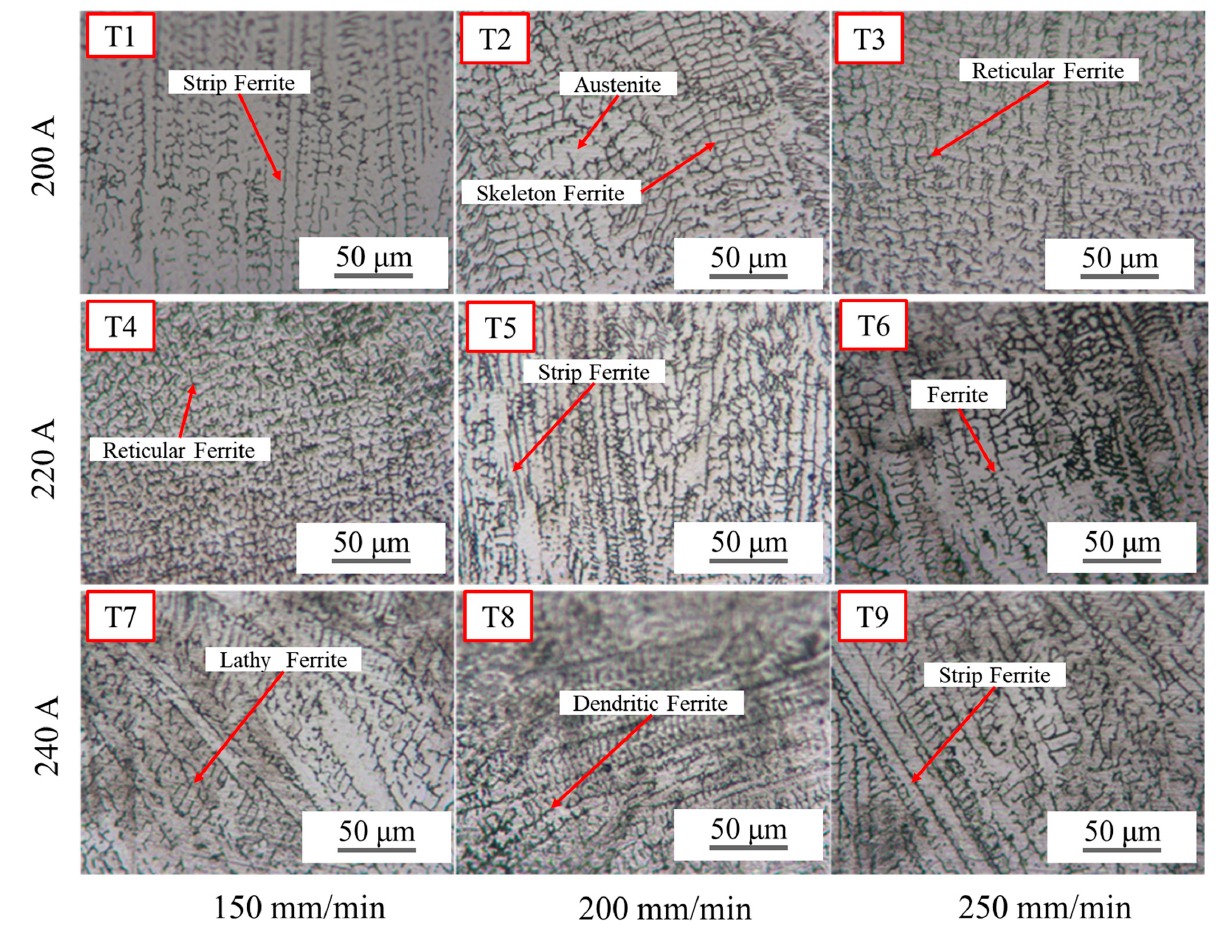
Figure 2. Micrographs of T1–T9 welds.